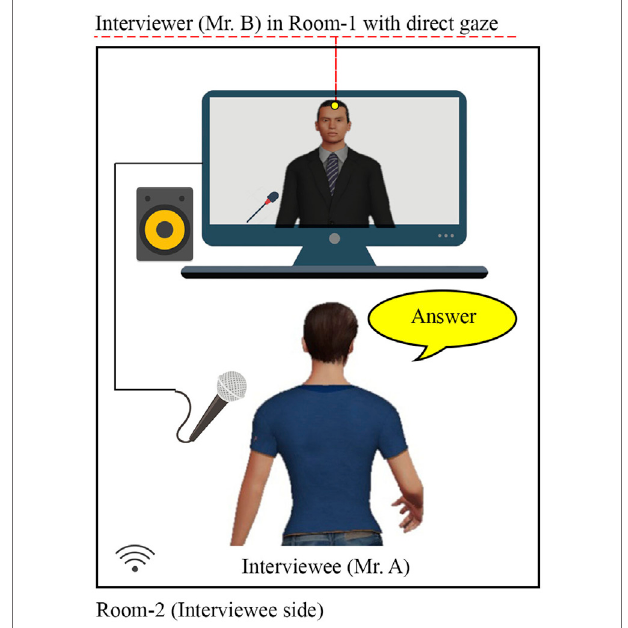
FIGURE 2 | Human condition of Experiment- Ⅰ (with interviewer ’ s gaze toward the interviewee).